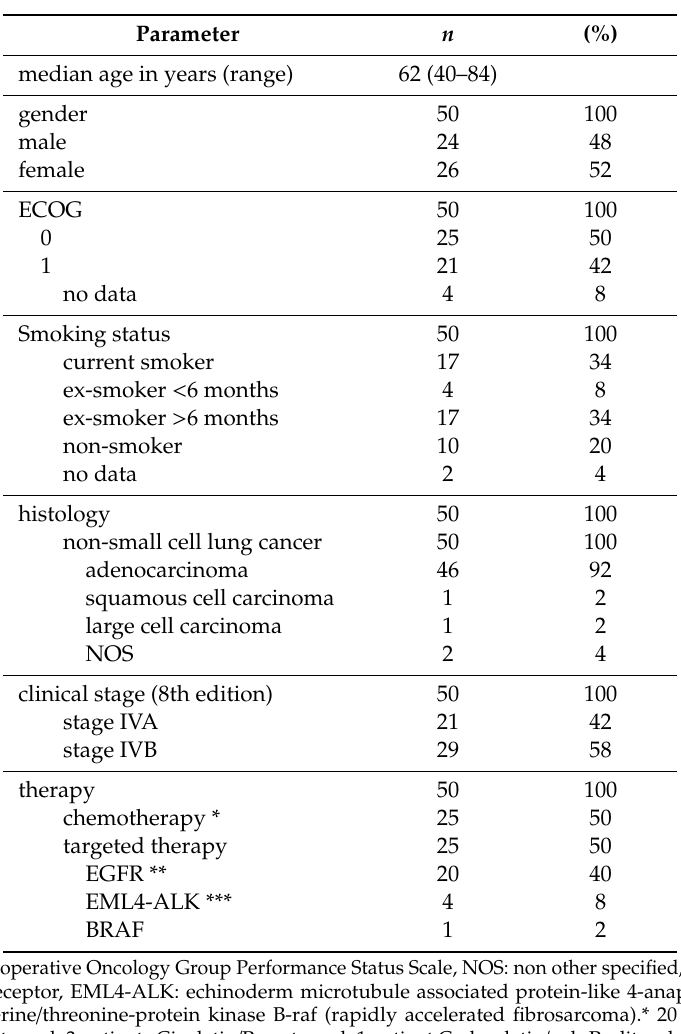
Table 1. Patient characteristics.